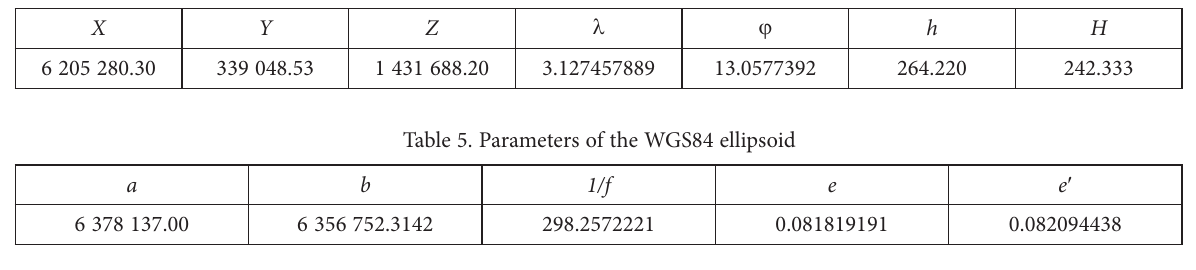
Table 4. Coordinates of point no.65 in WGS84 released by IGNN